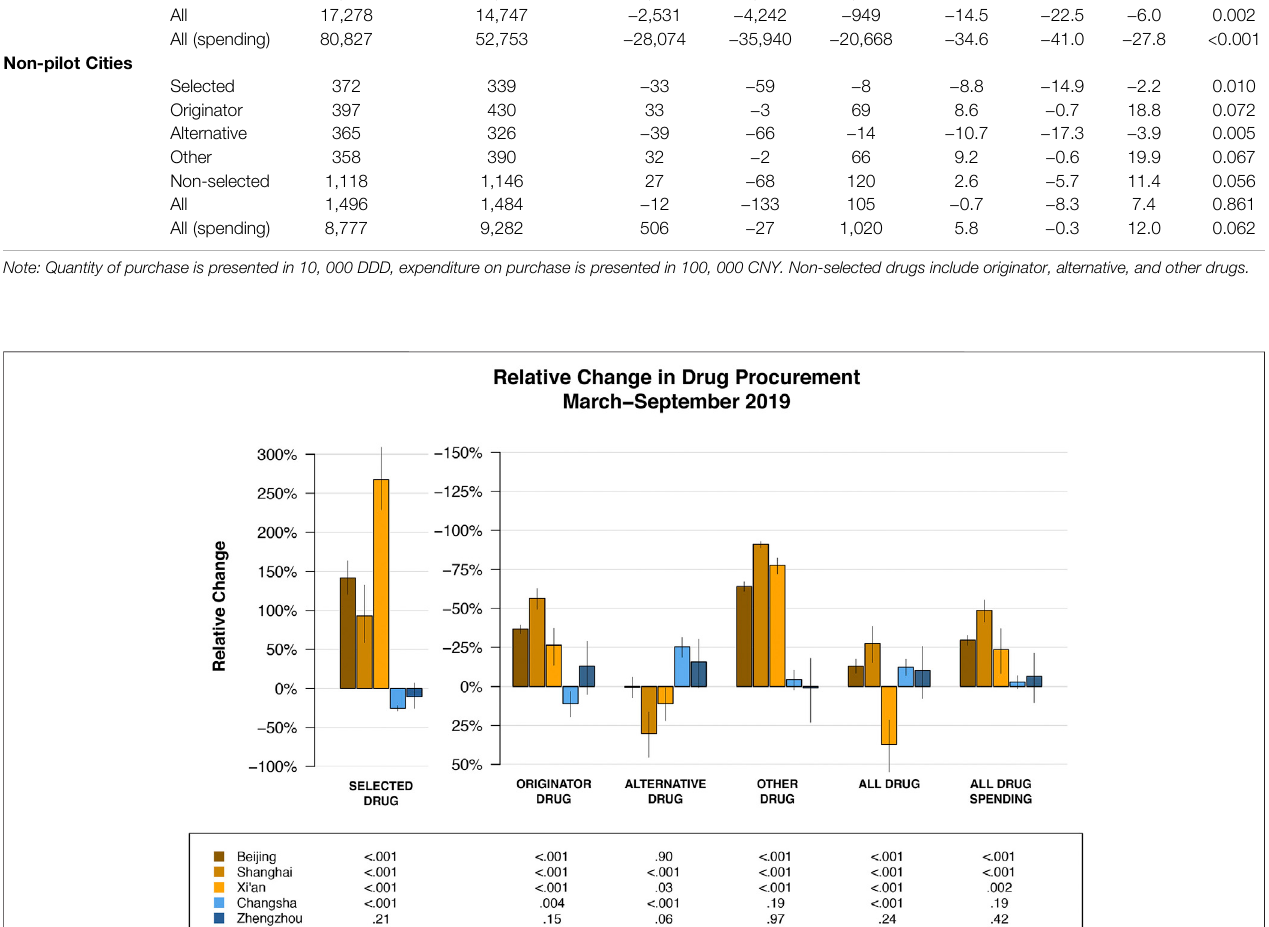
three disease types was either not statistically signi fi cant or only marginally statistically signi fi cant.